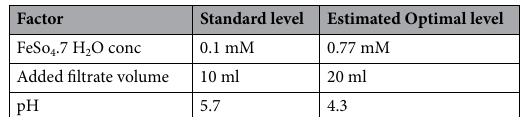
Table 6. Summary of the optimal levels estimated by Box-Behnken